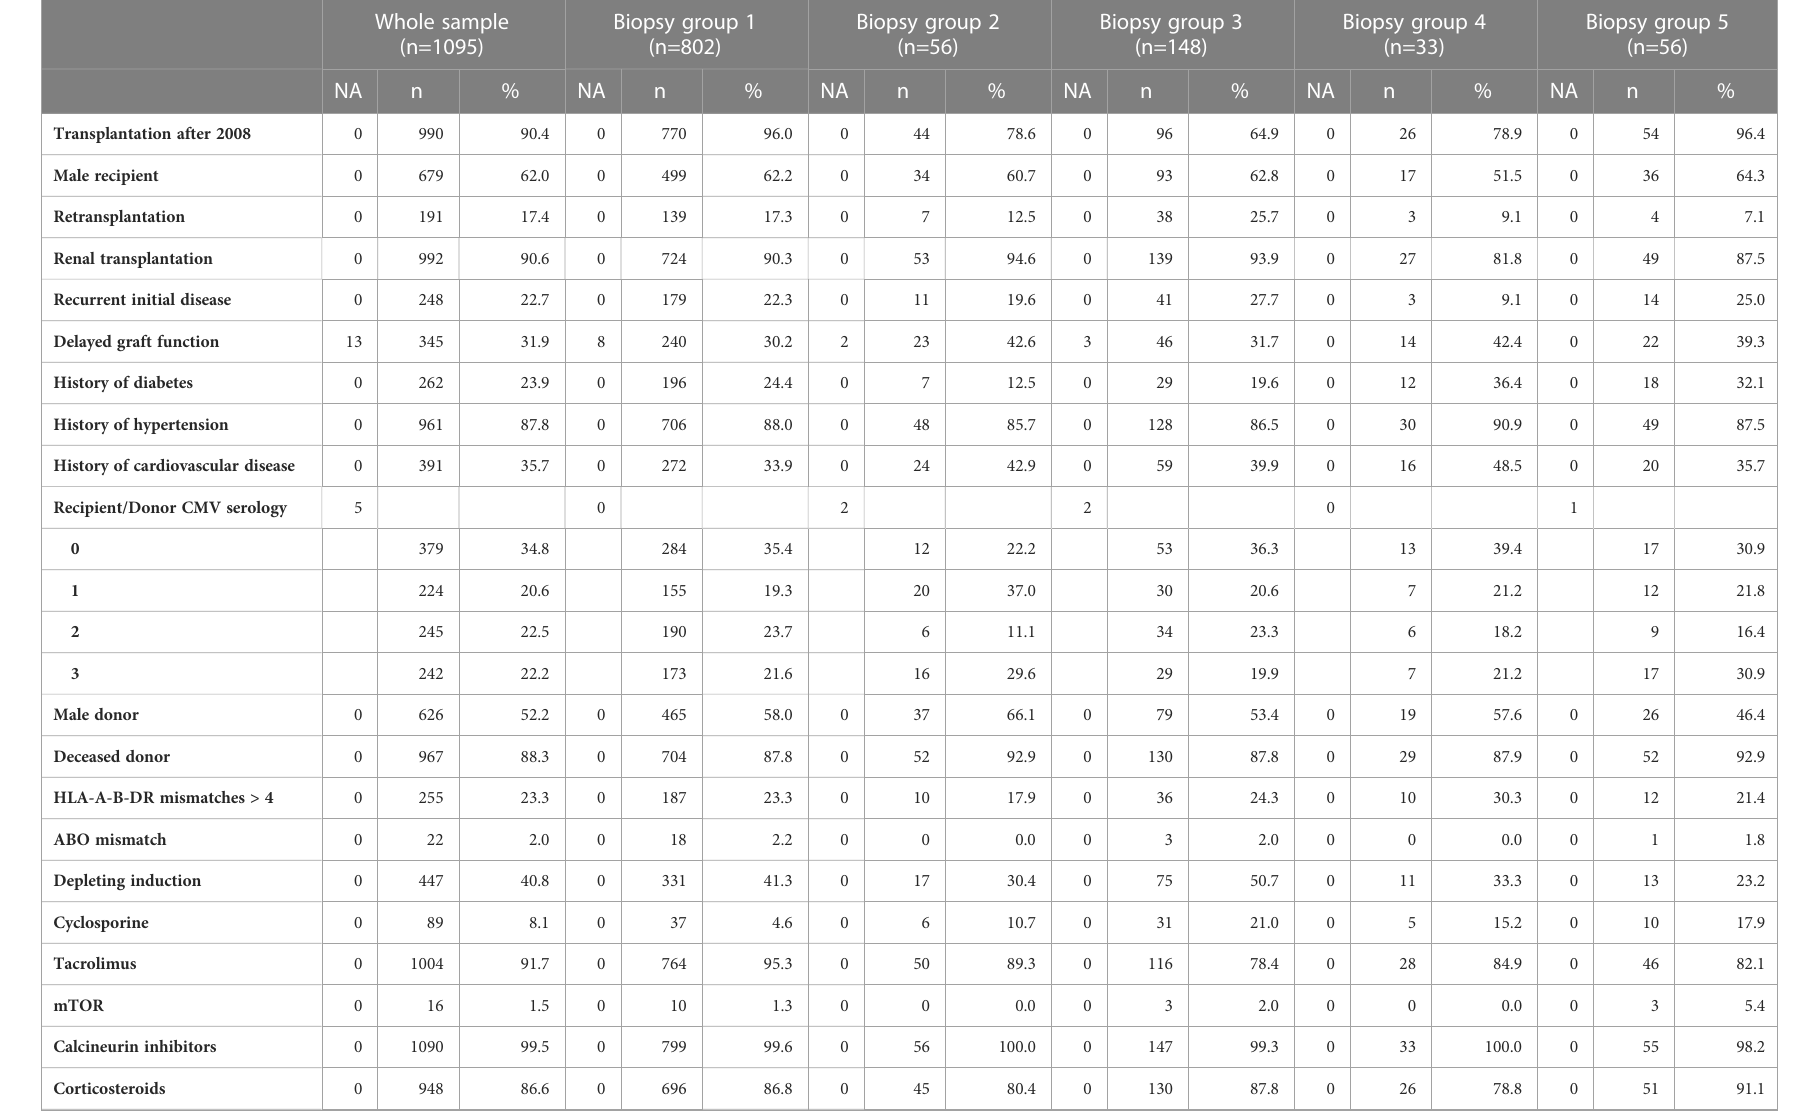
TABLE 1 Characteristics of 1095 renal biopsies included in the analysis according their biopsy